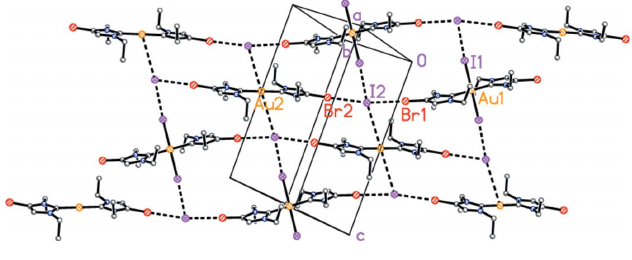
Figure 5 Packing diagram of compound 4 viewed perpendicular to (103). Hydrogen atoms are omitted. Dashed lines indicate halogen bonds or Au (cid:2)(cid:2)(cid:2) I contacts. Atom labels correspond to the asymmetric unit.